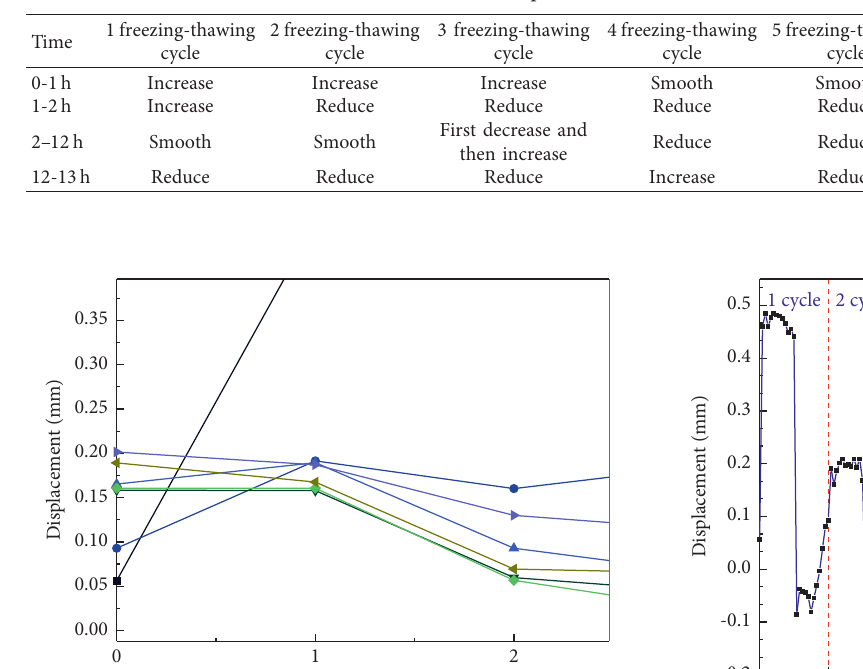
Table 6: The variation trend of displacement with time under different freezing-thawing cycles.